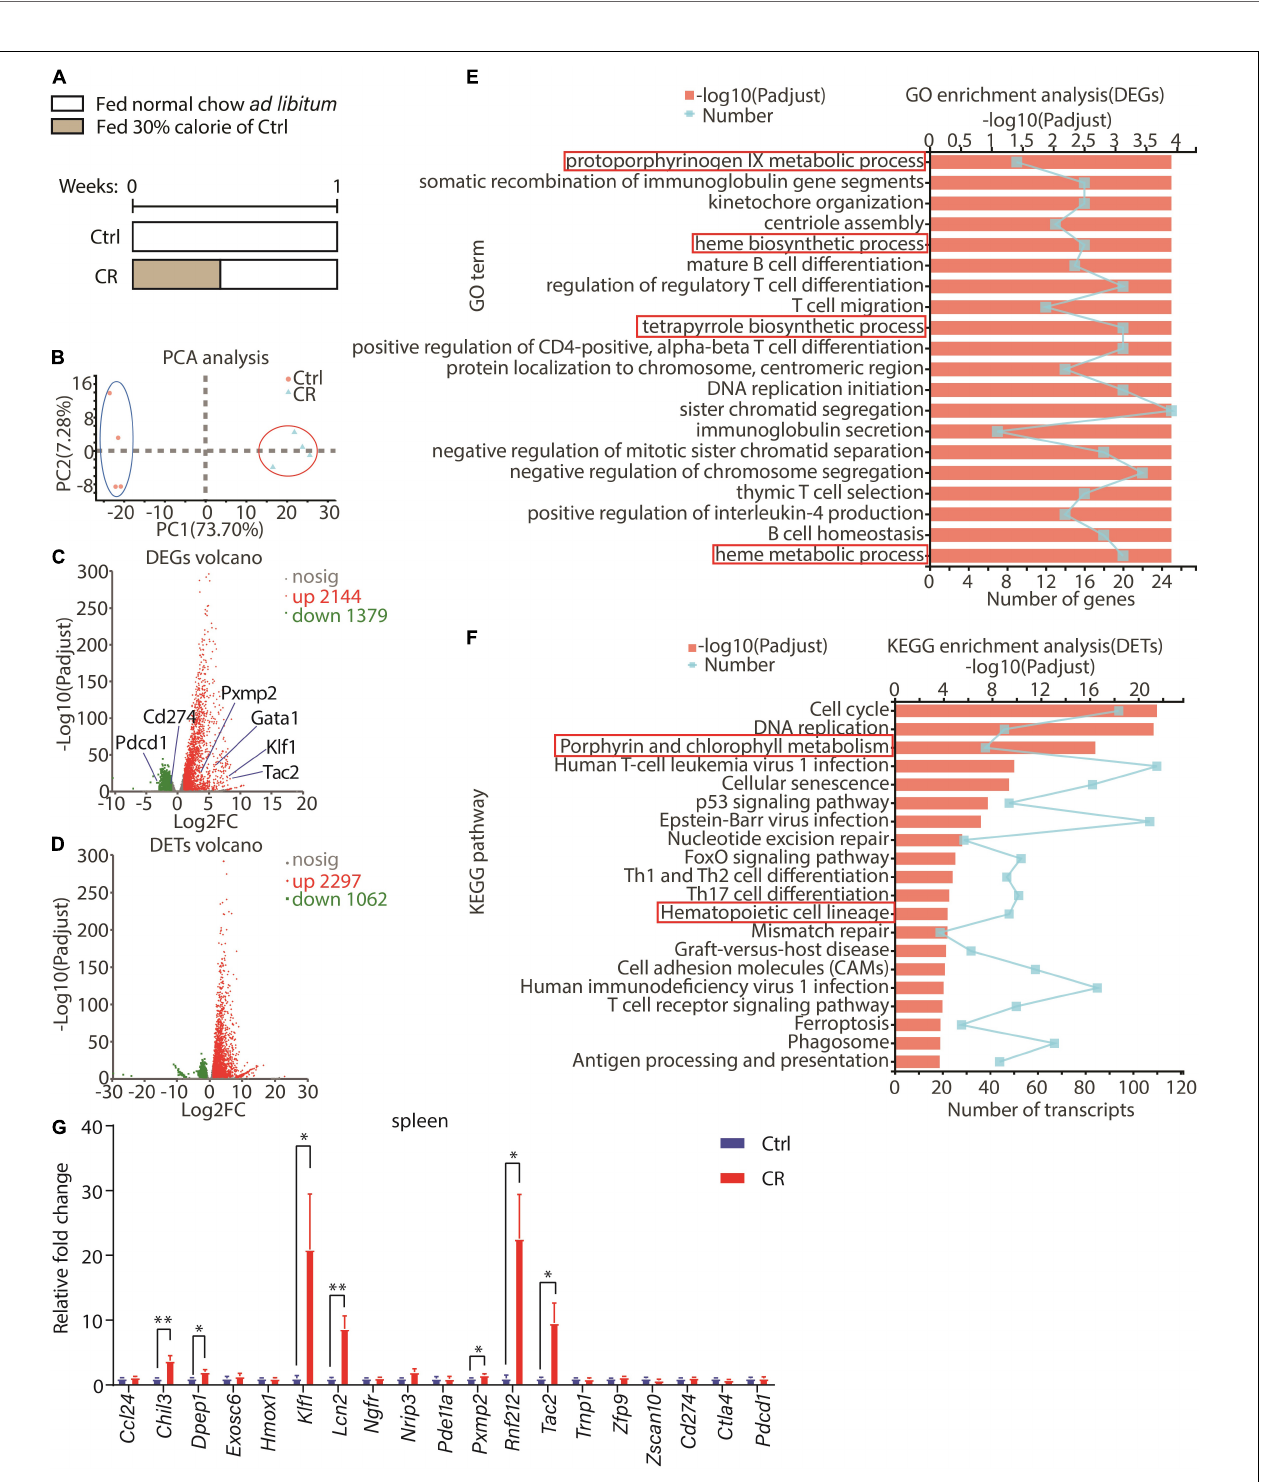
FIGURE 1 | Effect of a short-term CR on gene expression profile in spleen. (A) A schematic diagram showing the design of the experiment. Seven-week-old male C57BL/6 mice were divided into two groups: control with normal chow ad libitum (n = 4) and CR with 30% calorie intake for 3 days followed by free eating for 4 days ( n = 4). (B) Principal components analysis (PCA) was conducted between control and CR groups according to RNAseq data of the spleen. (C,D) Volcanos of differential expressed genes (DEGs) or transcripts (DETs) between the two groups. The data were both filtrated with P -adjust < 0.01 and fold change > 2 or < 0.5. (E) GO enrichment analysis of DEGs with top 20 GO terms shown here. The data were filtrated with P -adjust < 0.5 between the two groups. (F) KEGG enrichment analysis of DETs with top 20 KEGG pathways shown here. The data were filtrated with P -adjust < 0.5 between the two groups. (G) Results of quantitative RT-PCR for representative genes ( n = 4 for each group). The data are presented as mean ± S.E.M. ∗ P < 0.05 and ∗∗ P < 0.01.